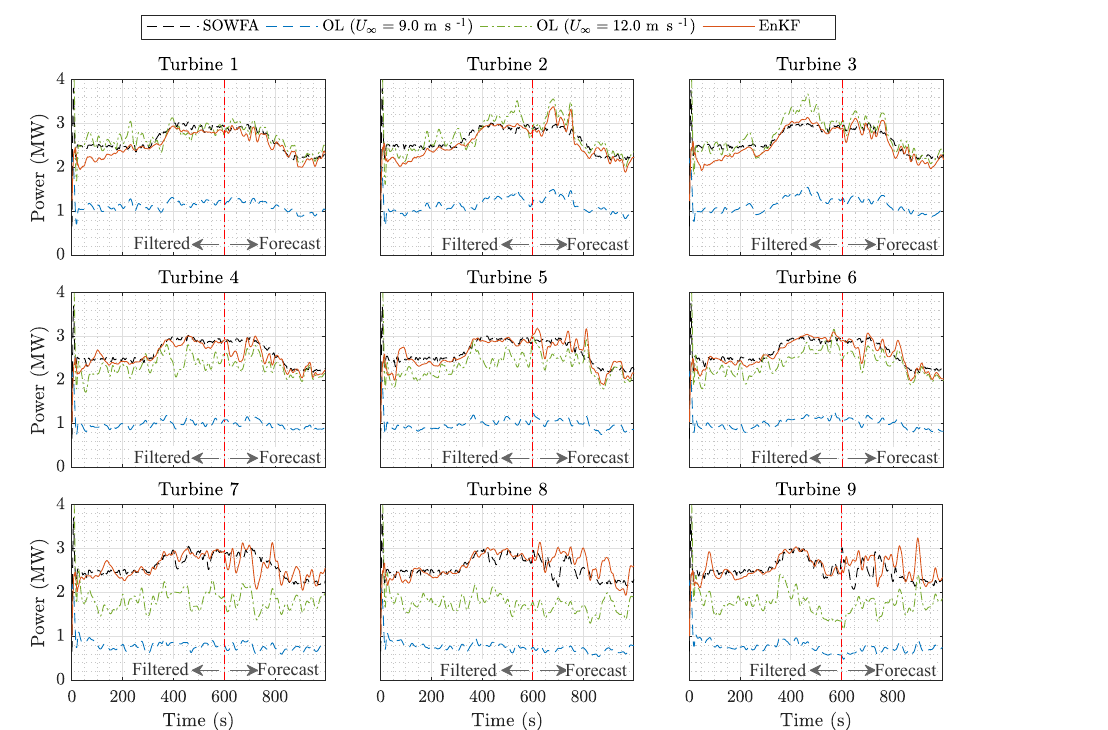
Figure 9. Comparison of power forecasting using the EnKF with measurements available up until time t = 600s. After convergence U ∞ (as seen as a positive power slope for the first row of turbines), (cid:96) s is also calibrated. After convergence, forecasting is better than in open-loop. Oscillatory behavior is still present due to an oscillatory input signal ( C (cid:48) ), turbulent flow field, and the absence of inertia in the rotor model. T